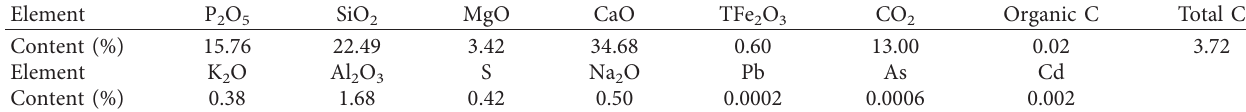
Table 1: Results of multielement analysis of phosphate tailings.